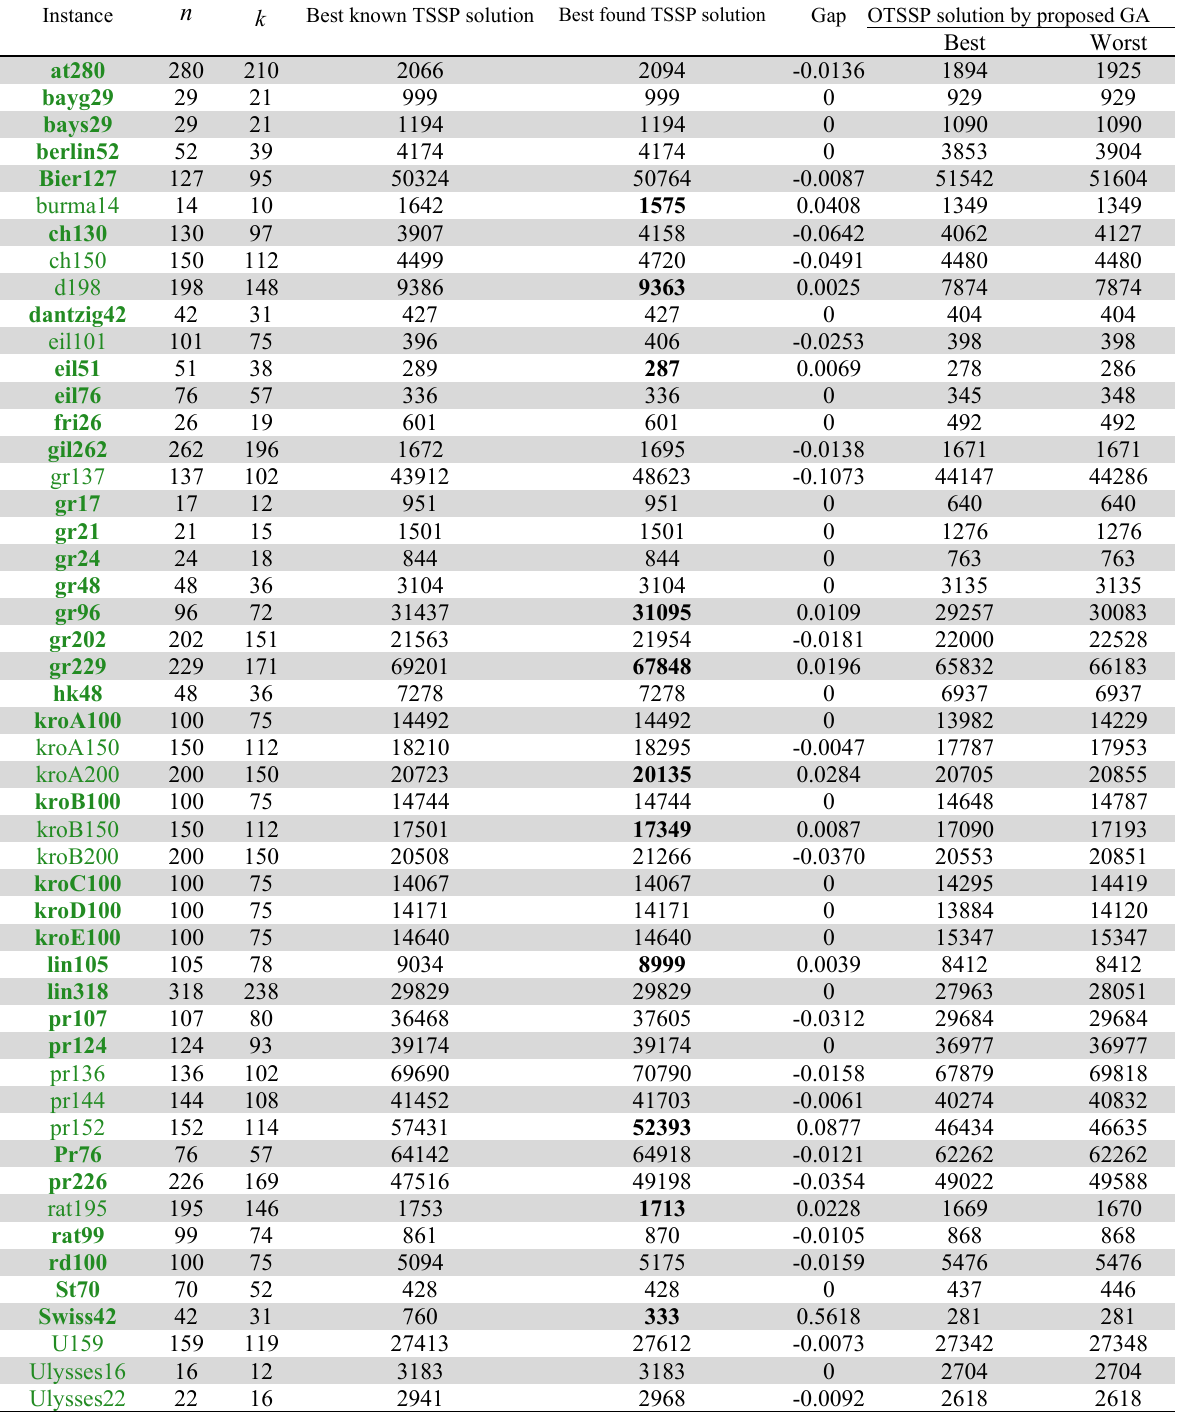
Computational results of proposed GA on instances